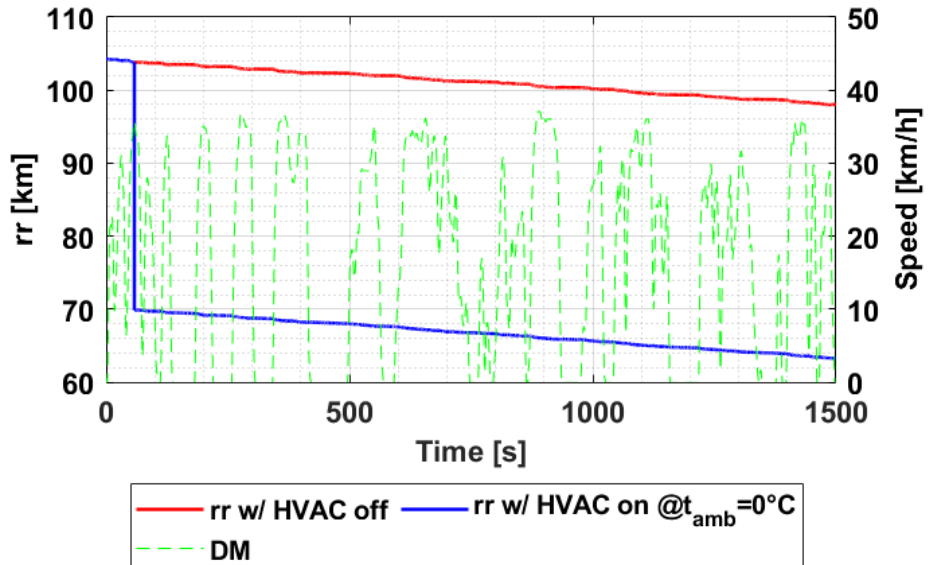
Figure 31. Evolution of the residual range variation with and without the HVAC system consump- tion for DM 20 considering the winter scenario (0 °C).